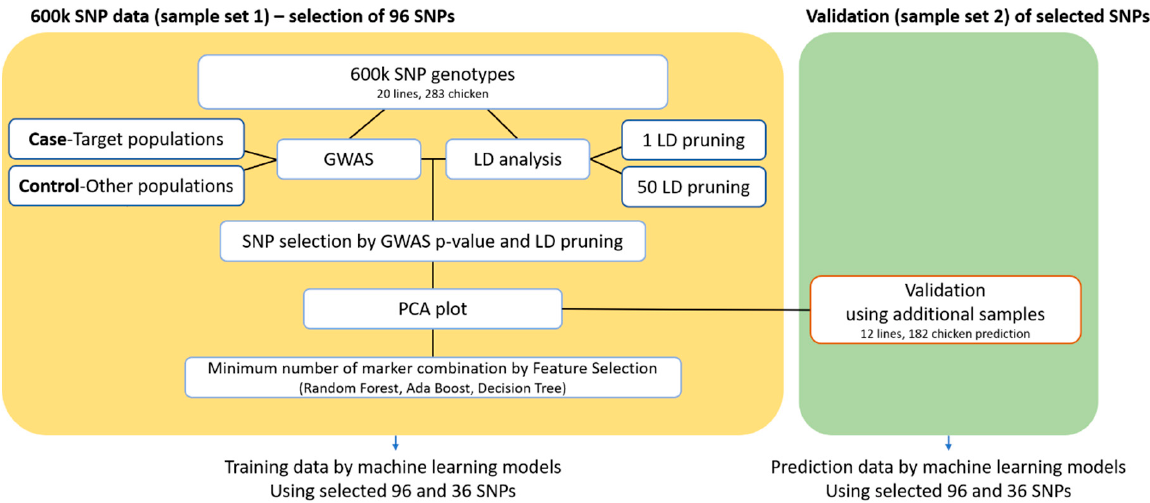
Figure 1. Workflow of the process applied to determine the marker combination with the minimum number of markers required for target population identification. In the validation step, a machine learning algorithm was applied to use Sample Set 1 (283) as training data and Sample Set 2 (182) as prediction data. SNP, single nucleotide polymorphism; GWAS, genome-wide association study for the case/control population; LD, linkage disequilibrium; 1 LD pruning, 1 SNP selected per 1 LD block; 50 LD pruning, 1 SNP selected per 50 LD blocks; PCA, principal component analysis .